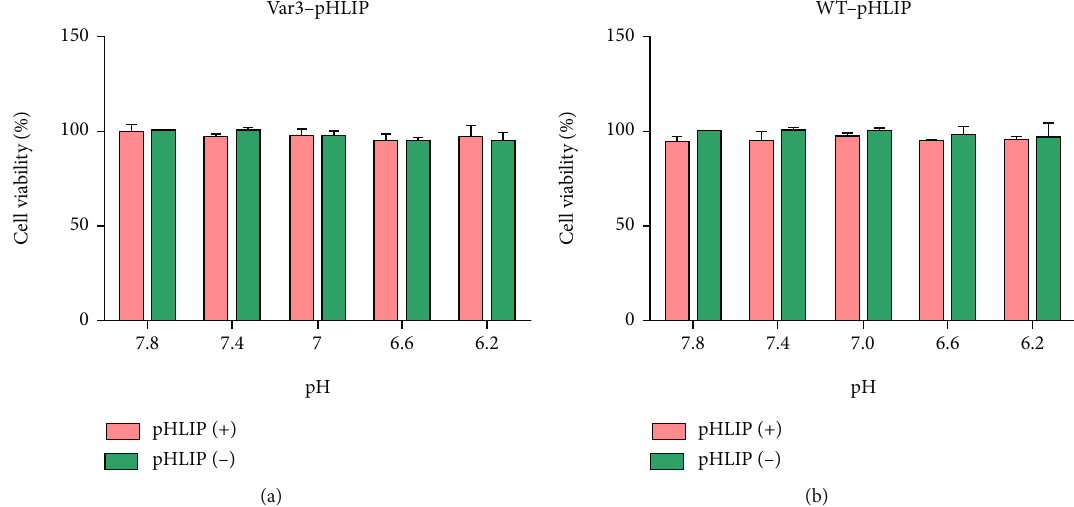
Figure 2: Cell Counting Kit-8 (CCK-8) assay showing cell viability. CCK8 assay showed no signi fi cant di ff erence in cell viability in MDA- MB-231 cell line after treatment with (a) FITC-Var3-pHLIP and (b) FITC-WT-pHLIP under di ff erent pH